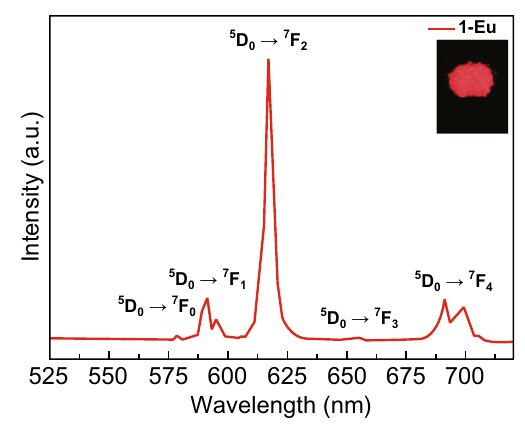
Fig. 11 Solid-state emission spectrum of {[Eu(L)(H 2 O) 2 ]·5H 2 O} n at 254 nm at room temperature. Reprinted with permission from